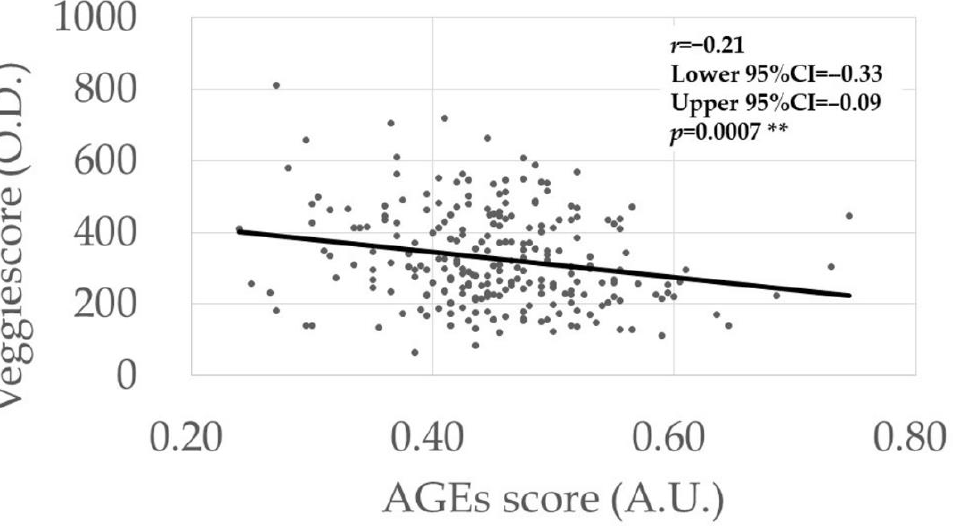
AGEs score (A.U.) The correlation coefficient ( r ) by Pearson’s correlation coefficient. Significance levels at 5% ( p < 0.05) * and 1% ( p < 0.01) **. CI, confidence interval; PR, pulse rate; cpm, count per minute; BMI, body mass index; BCVA, best-corrected visual acuity; IOP, intraocular pressure.